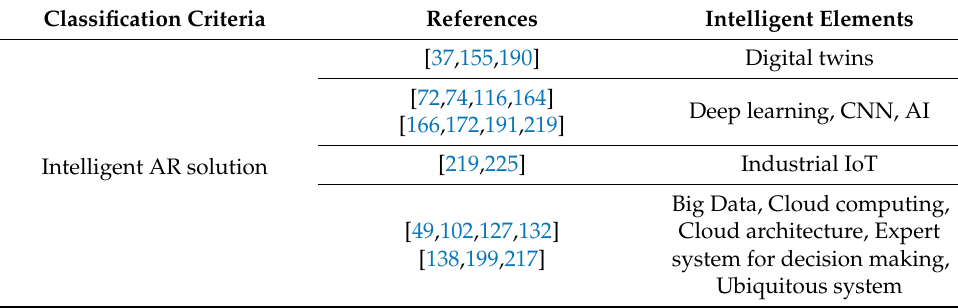
Table 11. Layer 5 Intelligent AR relevant articles